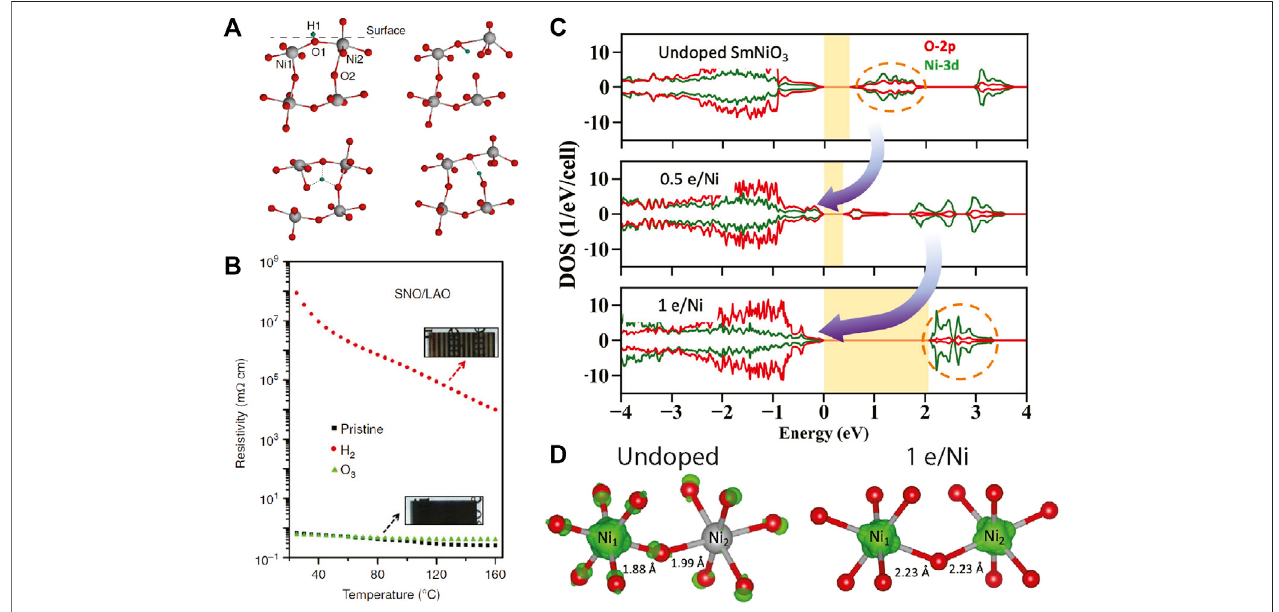
FIGURE 1| (A) Thediffusiveionicintercalationprocessexempli fi edbyhydrogen.Theproton(H+,ingreen)mainlybondswithoxygenandundergoesdiffusiverotation and transfer onto neighboring oxygen ions [35]. (B) Resistivity versus temperature for the pristine (black), hydrogen-intercalated (red), and ozone-annealed (green) SmNiO 3 thin fi lms grown on LaAlO 3 substrates (SNO/LAO). The resistivity increases by eight orders of magnitude upon doping [19]. (C) Density of states of undoped and electron- doped SmNiO 3 . (D) The squared modulus of the unoccupied intermediated band wavefunctions (green isosurfaces) [dashed-circles in (D) ]